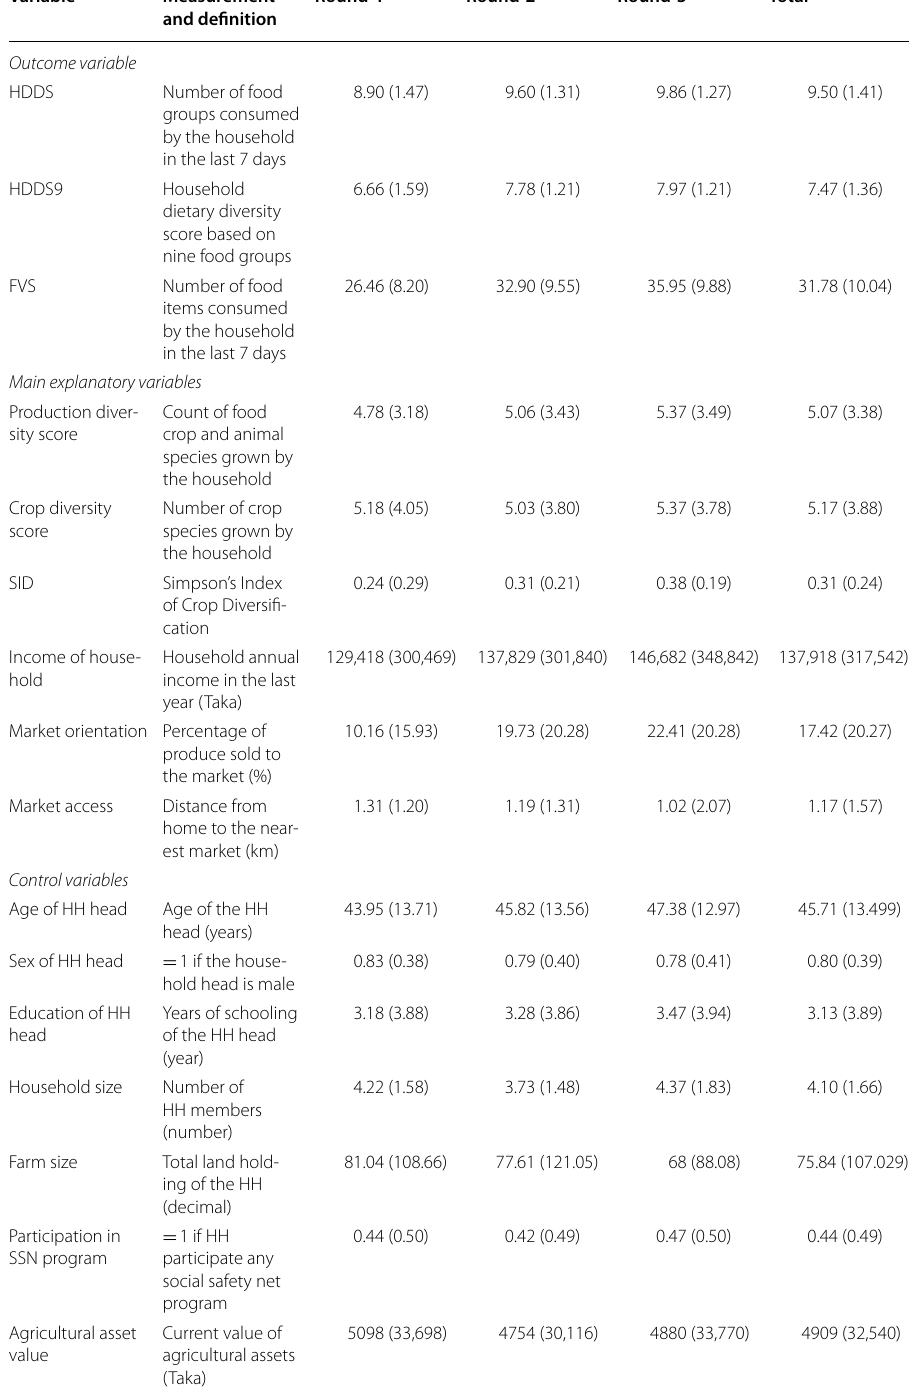
Authors’ analyses using 3 rounds of BIHS panel data. Mean values are shown with standard deviation in